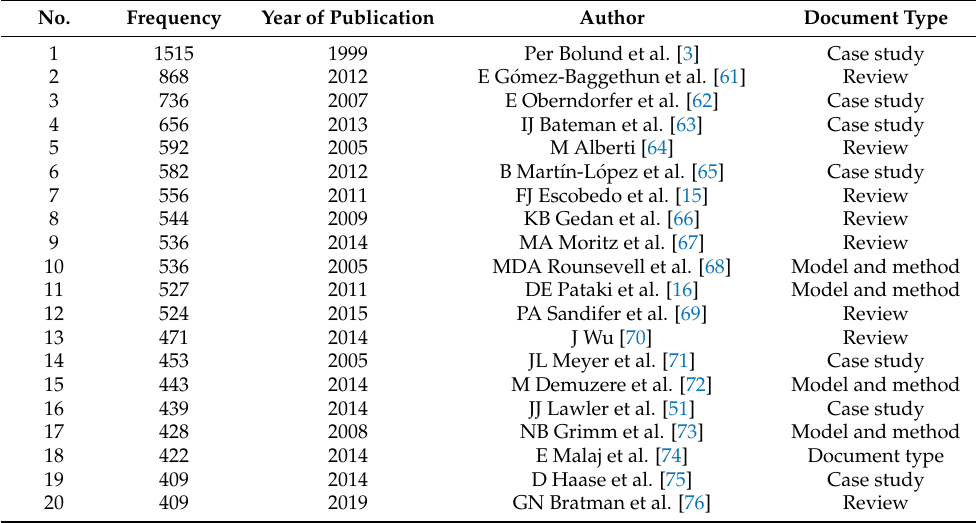
Table 6. Highly cited references on urban ecosystem services.